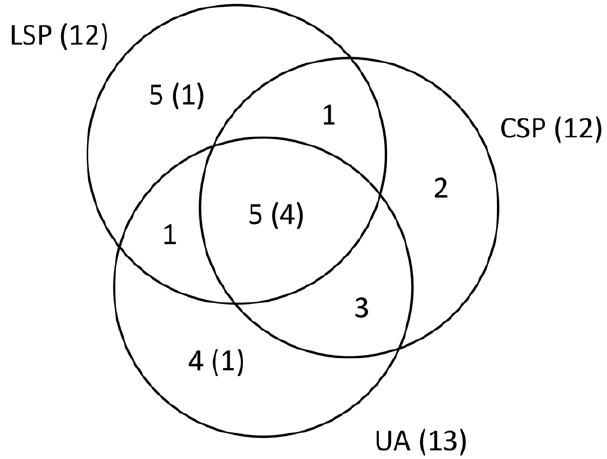
Figure 3. Number of host species as a function of the number of each type of parasite lineage recovered from three areas studied in Tocantins-Brazil. Plasmodium lineages are indicated by no fill symbols and Haemoproteus lineages are indicated by fill symbols. We can observer that one Haemoproteus lineage was presented in 21specimens from 17 different bird species. Genus is not a significant effect in an analysis of covariance (F1,18=2.2, P=0.15). The equation for the line is number of hosts= 2 0.007 ( 6 0.27 se) + 0.77 ( 6 0.04 se) number of infections (F1,19=377, P , 0.0001, R 2 =0.96).